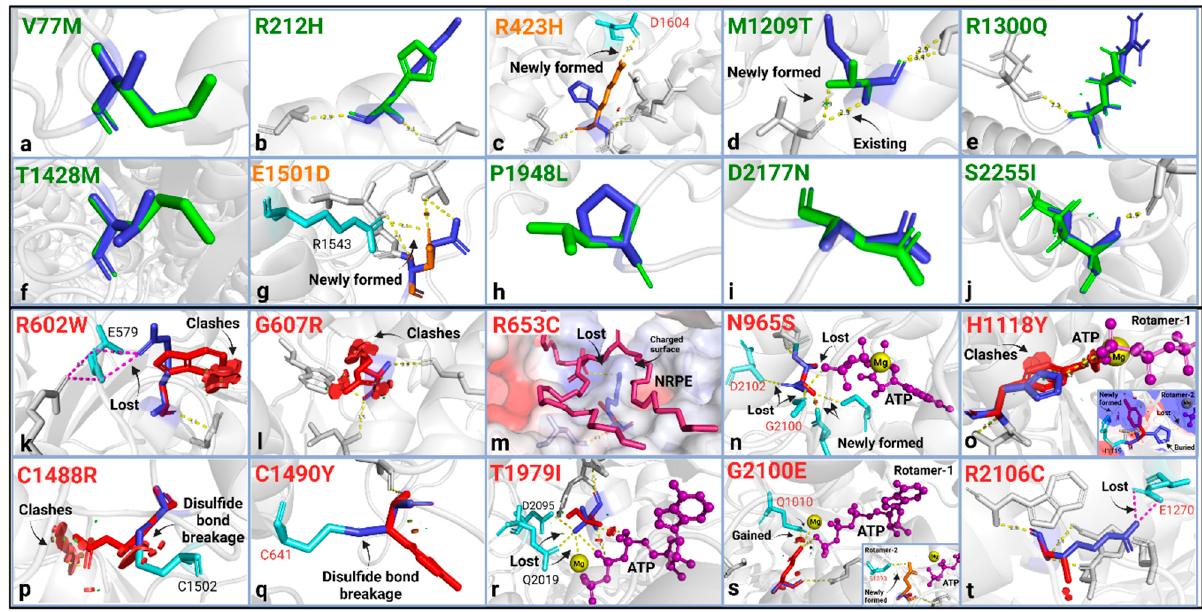
Figure 2. Highlights from the structural analysis of the benign ( a–j ) and pathogenic ( k–t ) ABCA4 variants. WT residue (blue) and the substitution (green when there is no change, orange for mild change, and red for substantial change) were shown as sticks with their structural effects using the “mutagenesis” feature in PyMol2. No structural change was found in the benign variants, except for two mild structural changes: ( c ) R423H and ( g ) E1501D, which are predicted to introduce a new salt bridge to the structure. Pathogenic variants: ( k ) R602W; broken salt bridge with E579 and